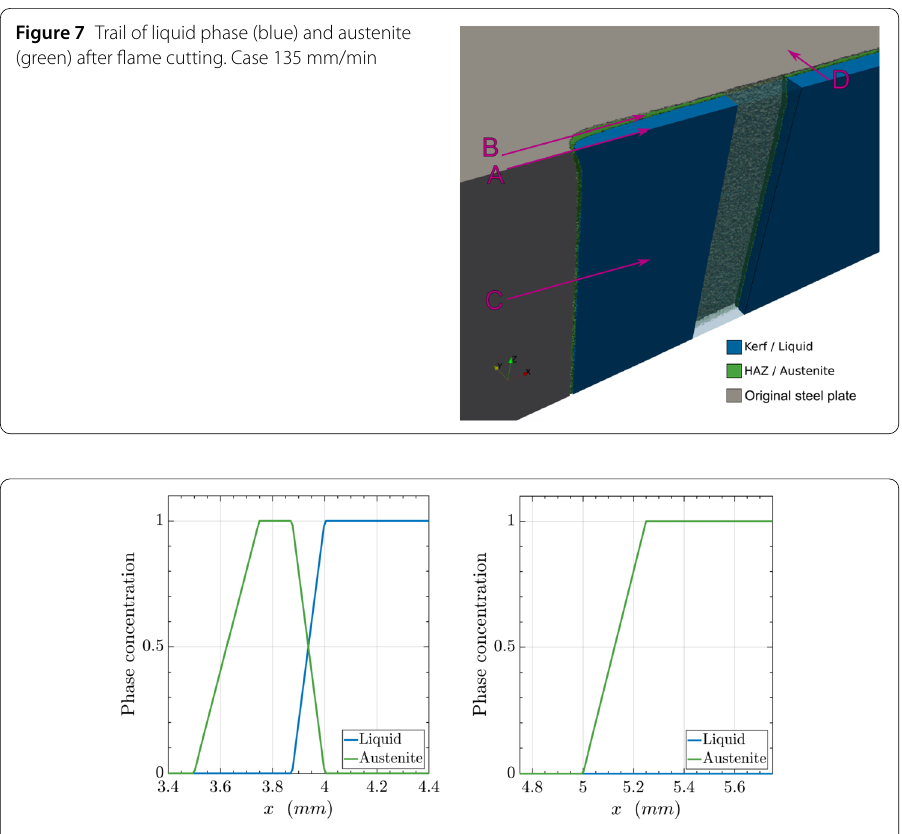
Figure 8 Evolution of phases along lines A (left) and B